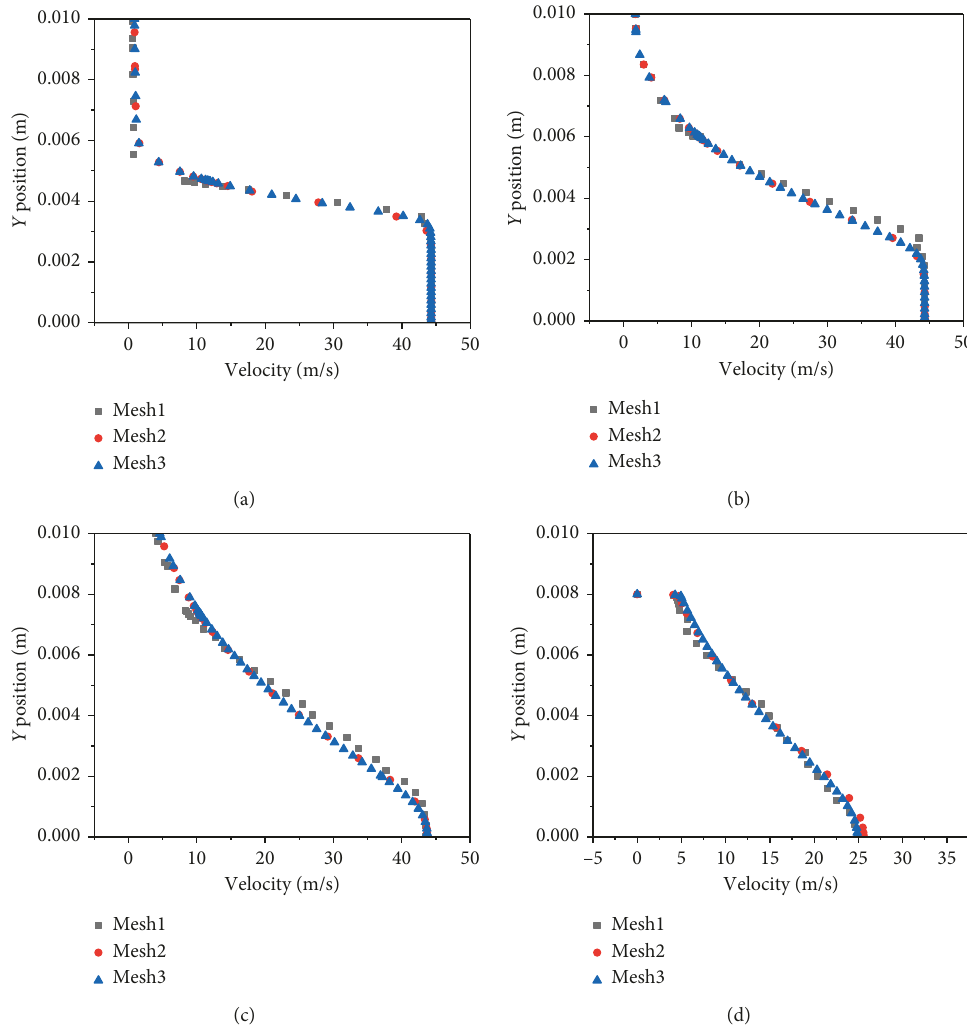
Figure 5: Distribution of monitoring line velocity. (a) Line 1. (b) Line 2. (c) Line 3. (d) Line